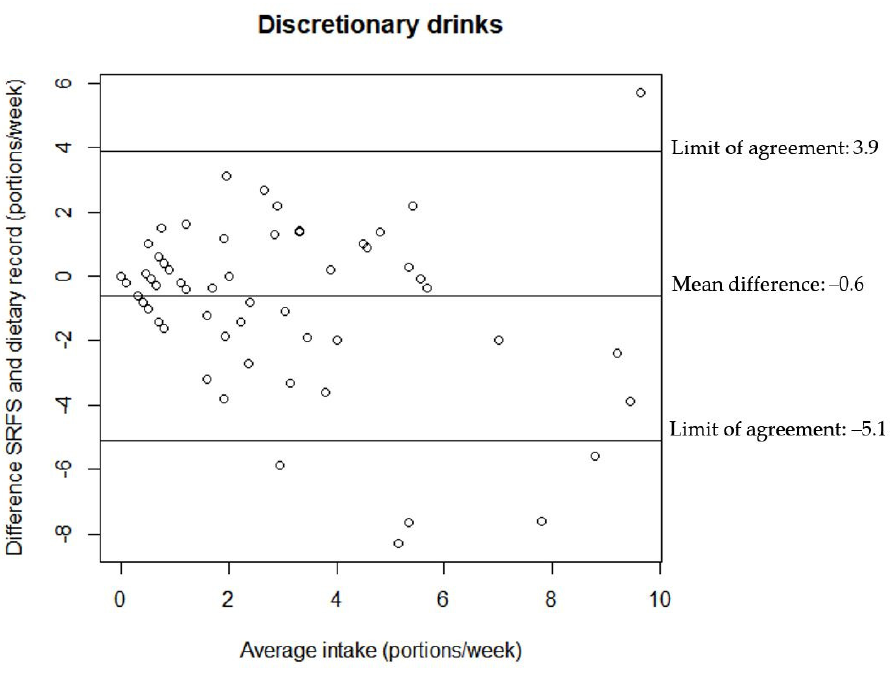
Figure 4. Agreement between the estimated portion intake of discretionary drinks from the SRFS and the 7-day dietary record ( n = 80).